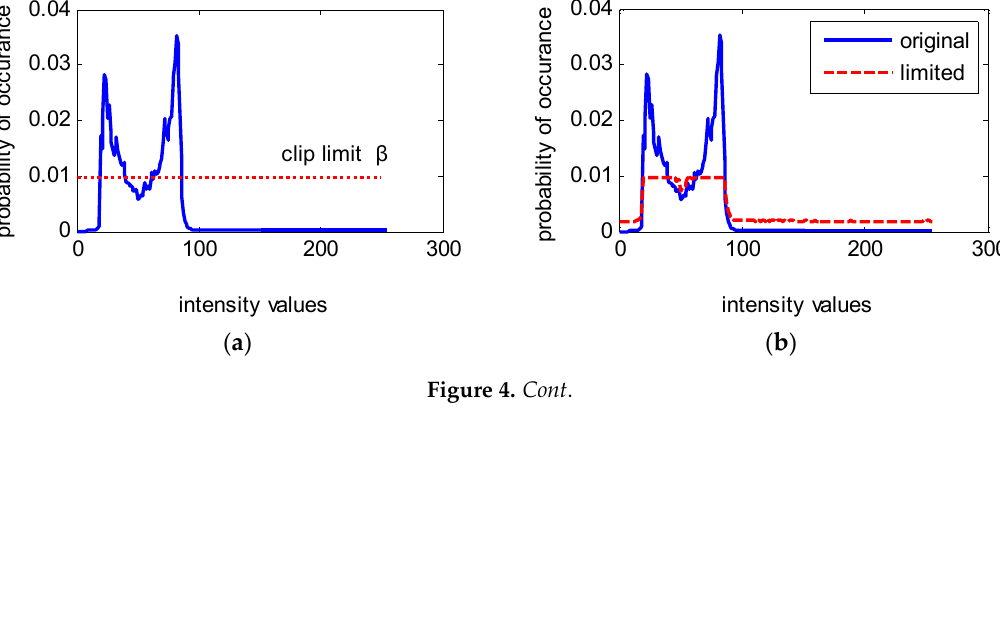
Figure 3. The example of enhanced results by the HE and the clipped HE method. ( a ) Original input image; ( b ) Image enhanced by HE; ( c ) Image enhanced by clipped HE with β = 2.5 N av ; ( d ) Image enhanced by clipped HE with β = 1.5 N av .